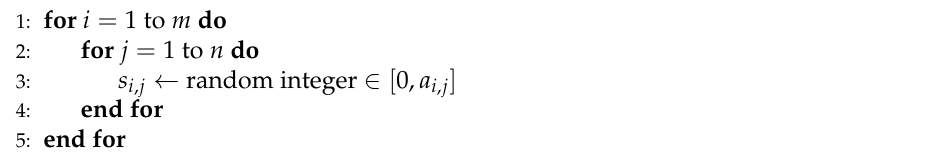
Algorithm 1 Non-deterministic polynomial certificate